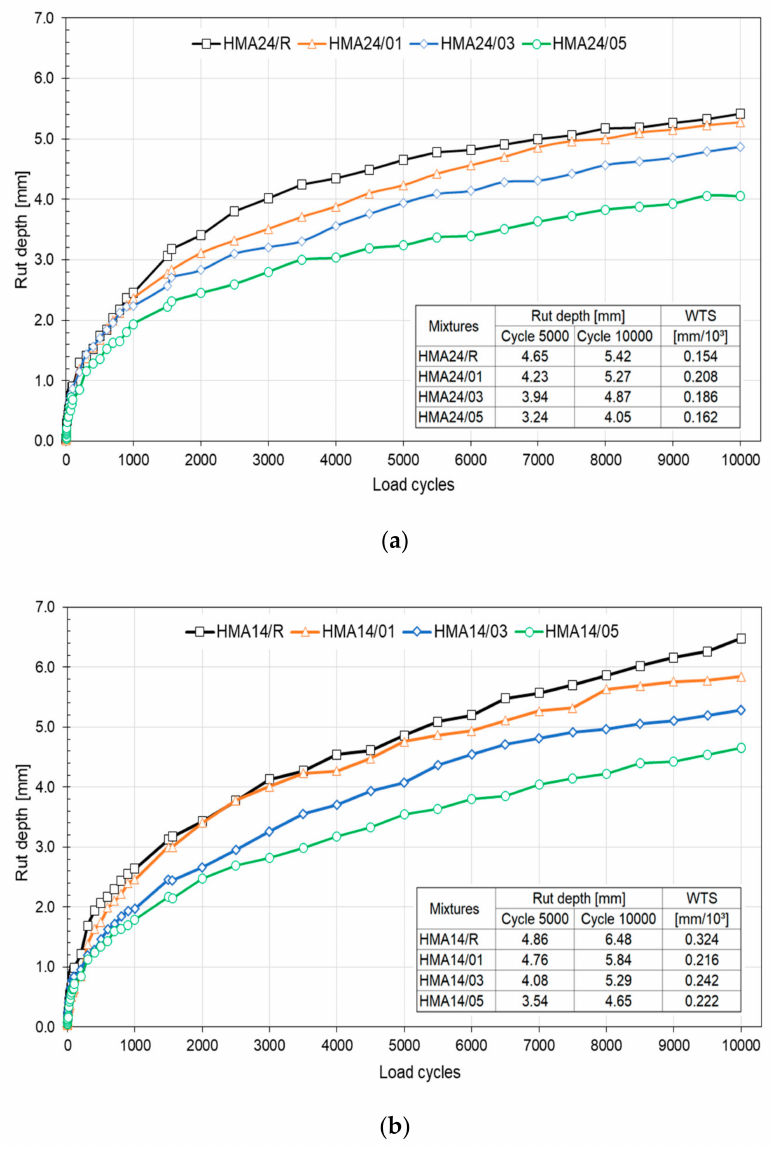
Figure 8. Hamburg wheel tracking test results at 50 ◦ C: ( a ) HMA24; ( b )